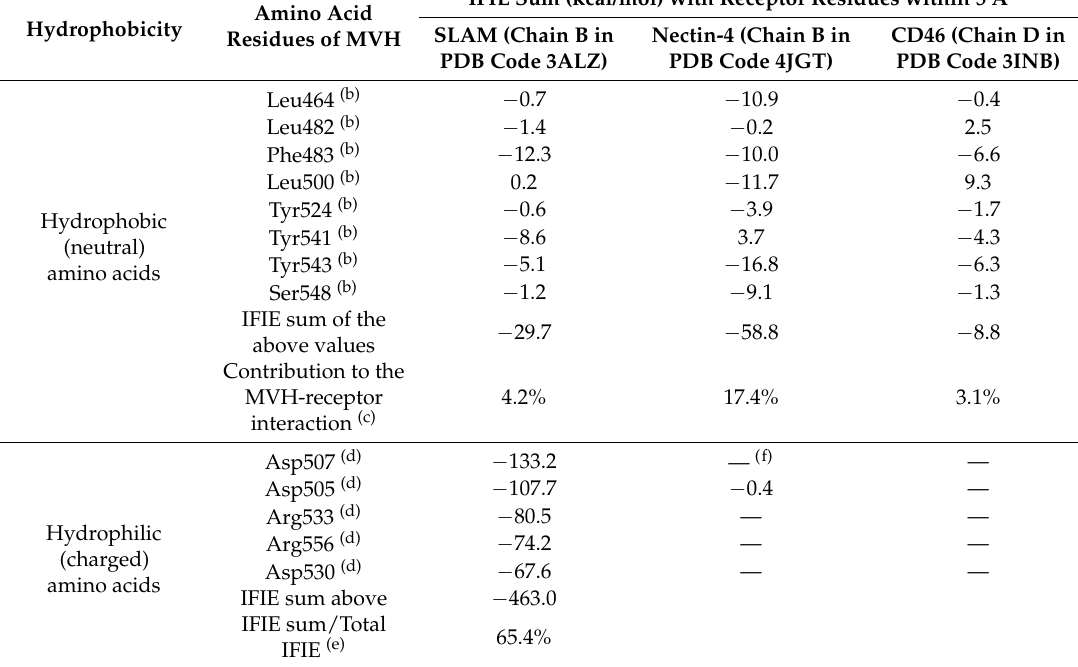
Table 3. Characteristic IFIEs between amino acid residues of MVH and three receptors, SLAM, Nectin-4, and CD46. The summations of these IFIE values over the MVH residues and their contributions to the total IFIE values in Table 1 are also